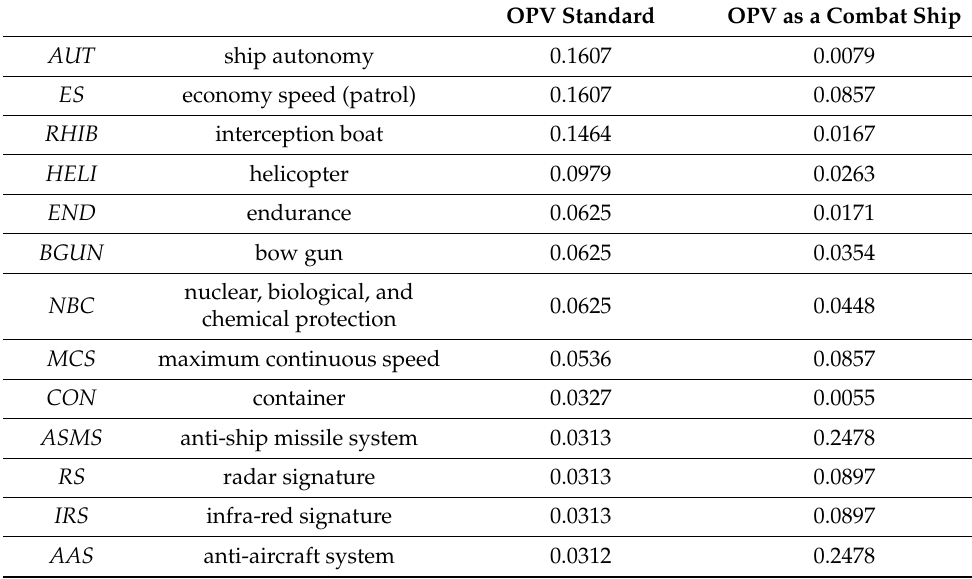
Table 3. Weight coefficients of OMOE-specific attributes K TK ( i